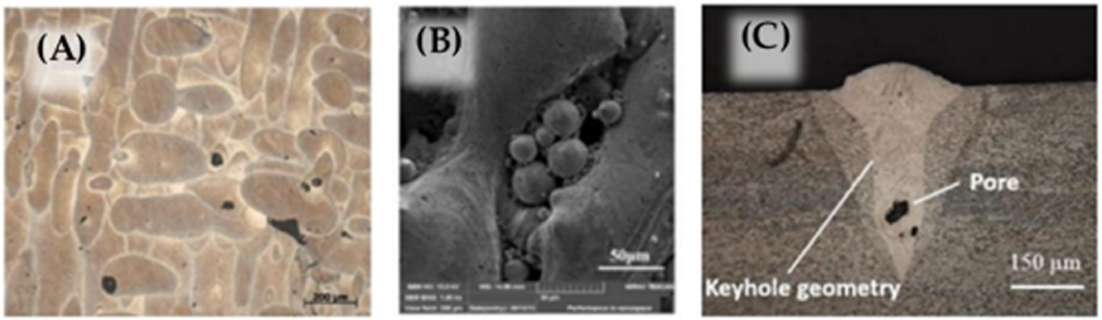
Figure 17. Spherical pores ( A ), unfused powder ( B ), and keyhole pore ( C